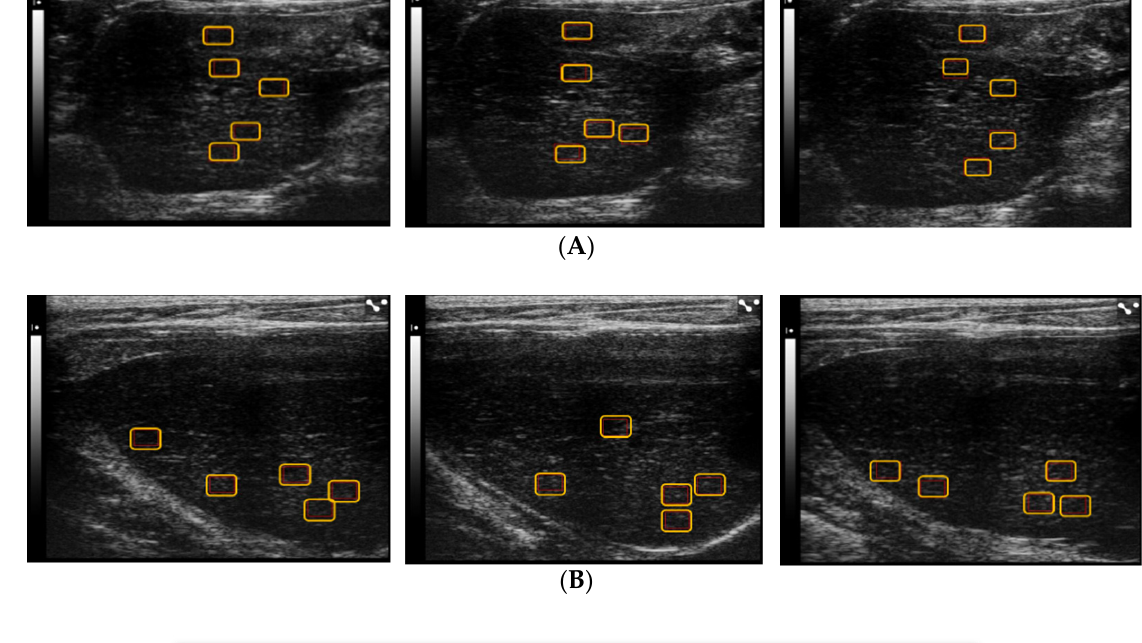
6 Table 2. Mean and standard deviation of intra- and inter-case JS divergence values for the three pathology groups.